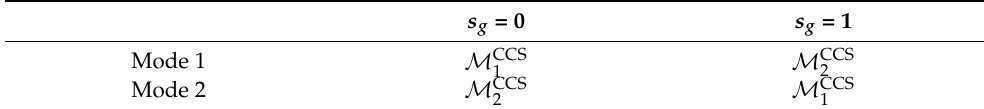
Table 1. Corresponding relationship of CMS in the g th